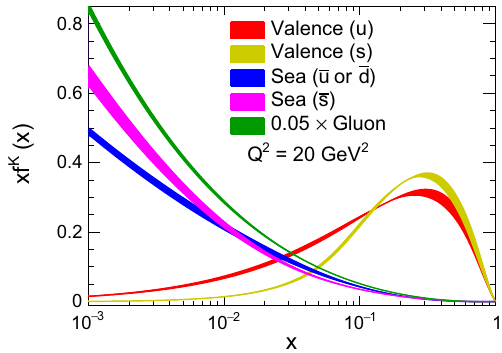
Fig. 6 The valence quark, sea quark and gluon distributions of the pion from this work. The error bands show the 3 σ uncertainties of the quantities